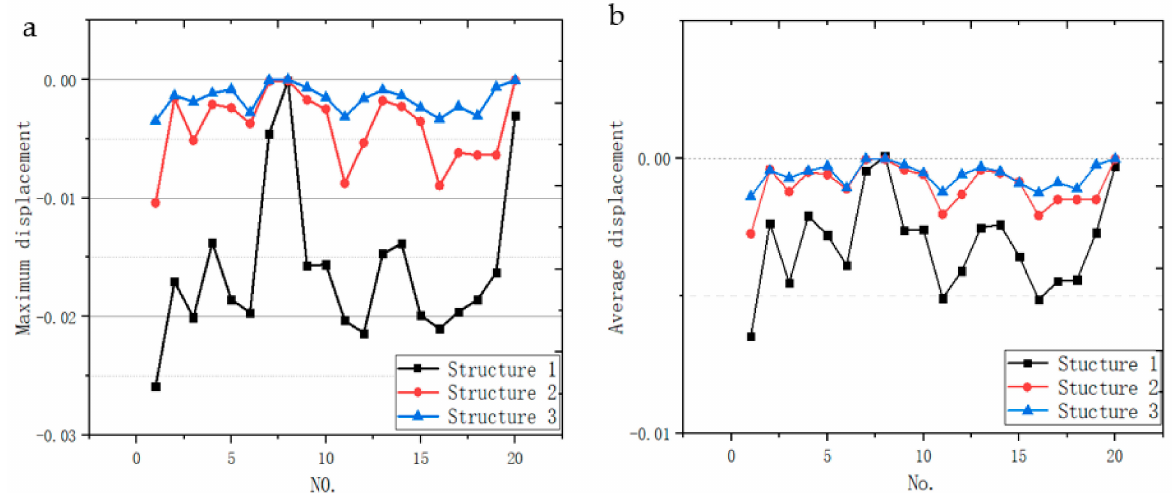
Figure 35. Comparison of displacements of bottom points of three structures under impact: ( a ) Maximum displacements; ( b ) Average displacements.